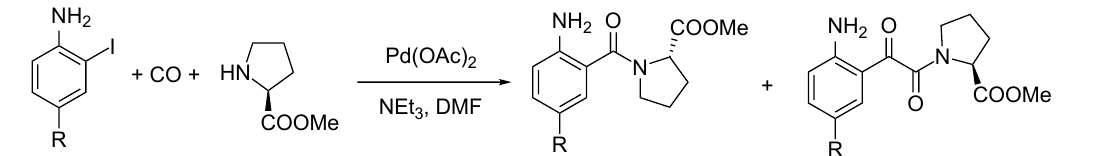
Figure 9. Pd-catalyzed aminocarbonylation of 2-iodoaniline in the presence of proline methylester. Reactive iodoalkenes, such as α -iodostyrene and α , α (cid:48) -diiodo-1,4-divinylbenzene were prepared and introduced into Pd-catalyzed aminocarbonylation. With all the N -nucleophiles only single CO insertion was observed, that is, N-substituted phenylacrylamid products were obtained chemoselectively [48].